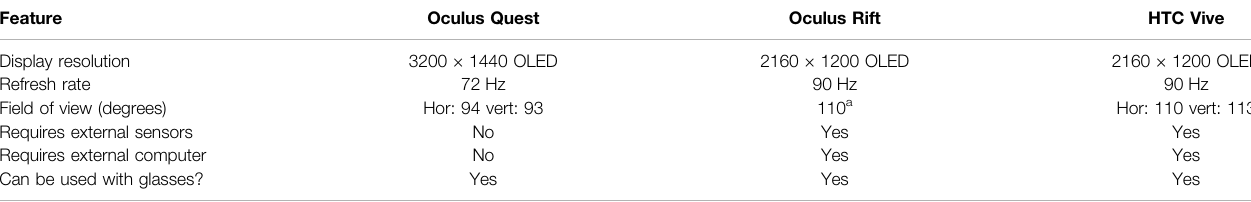
TABLE 5 | Comparison of features on Oculus Quest 9 , Oculus Rift 10,11 and HTC Vive (Borrego et al., 2018).